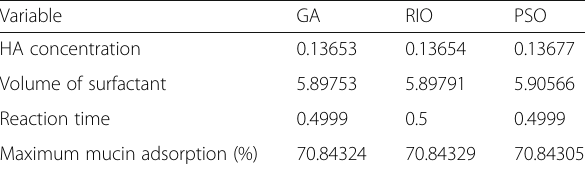
Table 5 Optimized conditions for mucin adsorption Table 6 Optimized conditions for